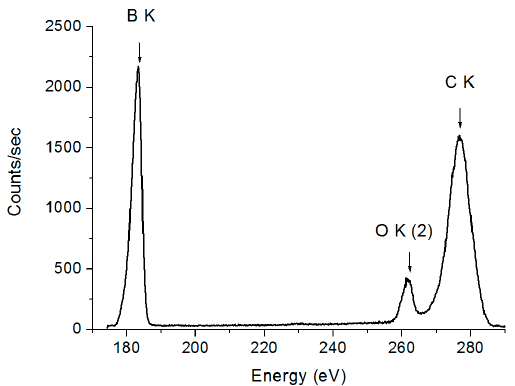
Figure 9. Boron metal spectra measured on RZP 1. The sample was naturally contaminated with a CO layer.